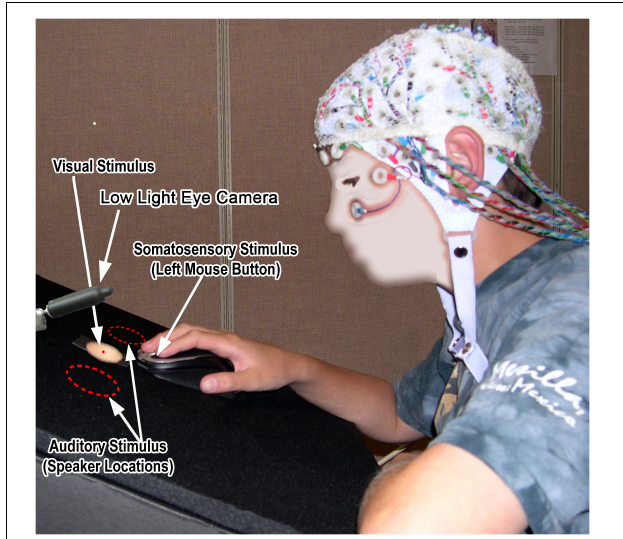
FIGURE 1 | Twelve-year child pilot participant seated at the tri-sensory stimulation